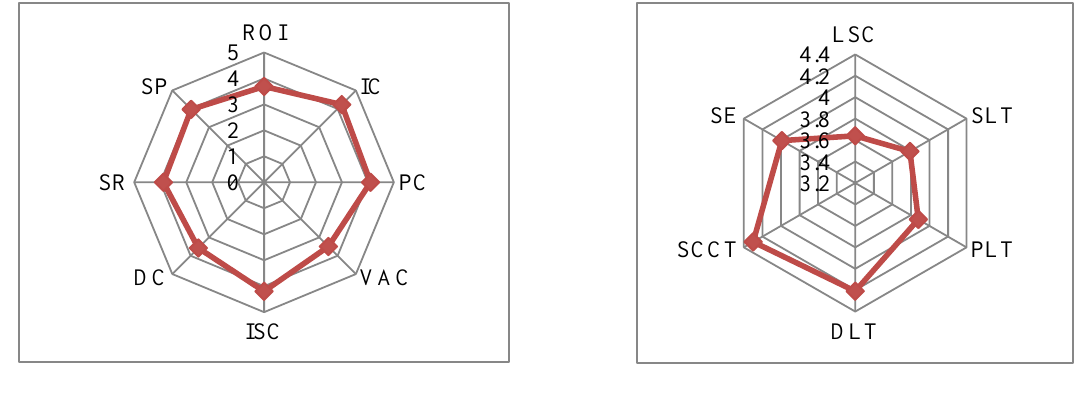
Fig. 4 Financial practices Fig. 5. Supply chain